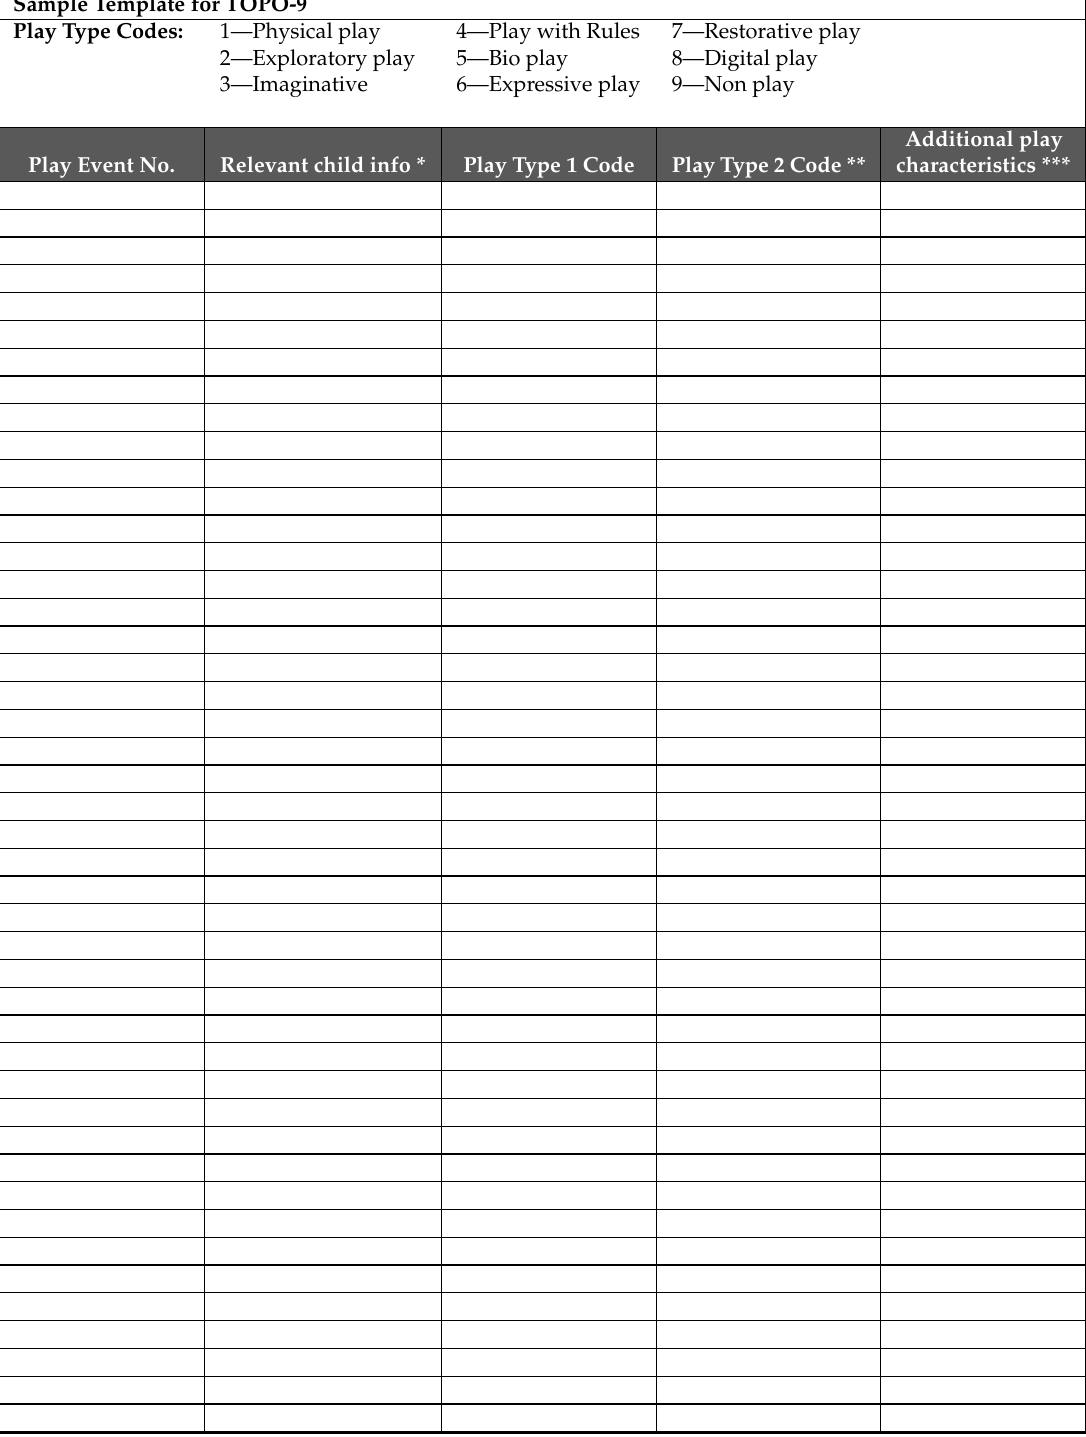
Table A1. Sample Template for TOPO-9 (Collapsed